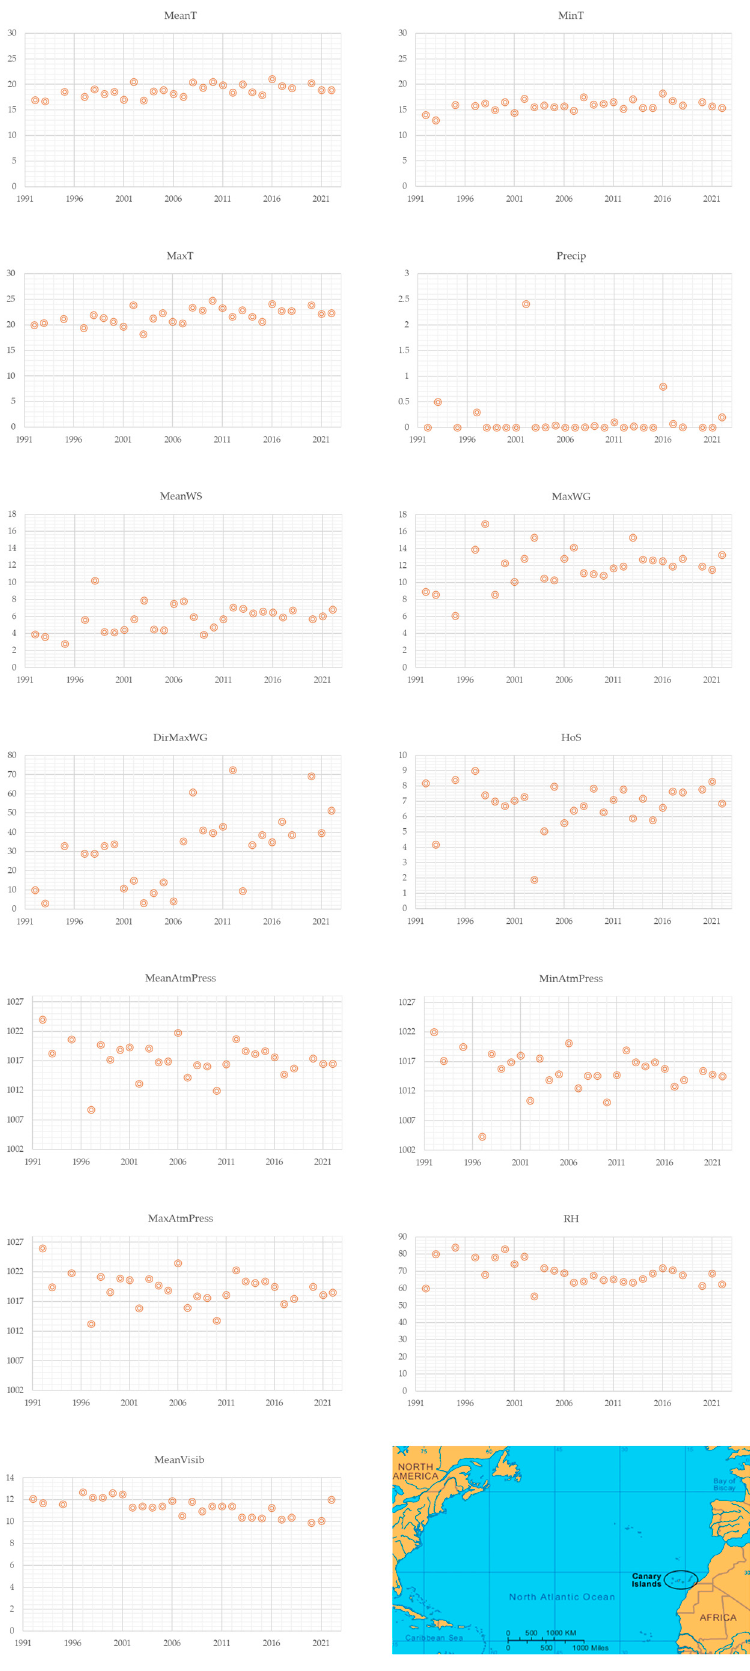
Figure 3. Interannual variation in the mean values for weather variables at the onsets of parturition registered each year. A map with the geographical location of the study area (black circle) is